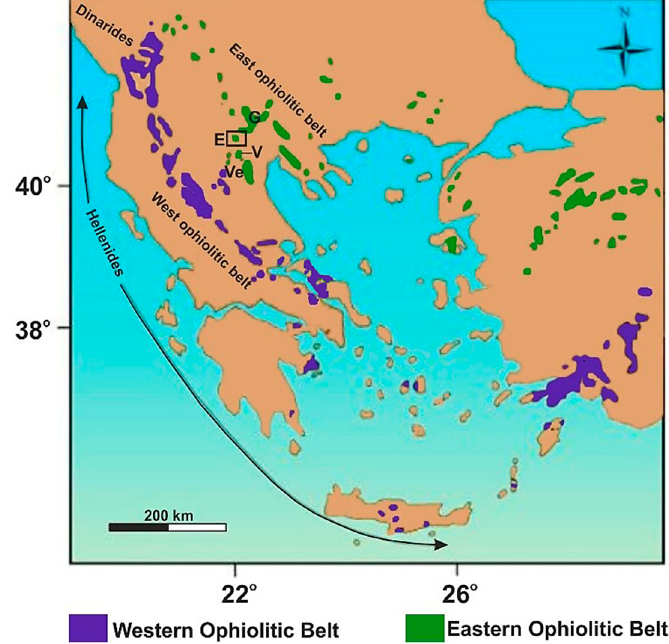
Figure 1. Distribution of ophiolites in the southernmost part of the Balkan Peninsula and Turkey (modified after Vérgely [34]). Key to lettering: E = Edessa (also marked by the open square), G: Guevgeuli, V: Veria-Naousa, Ve: Vermion.